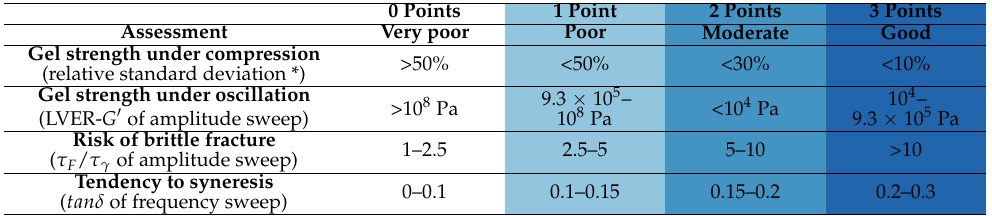
Table 6. An overview of the color-coded assessment system (parameters used in parentheses). The more points and the more intense the color, the better are the gel characteristics. 0 Points 1 Point 2